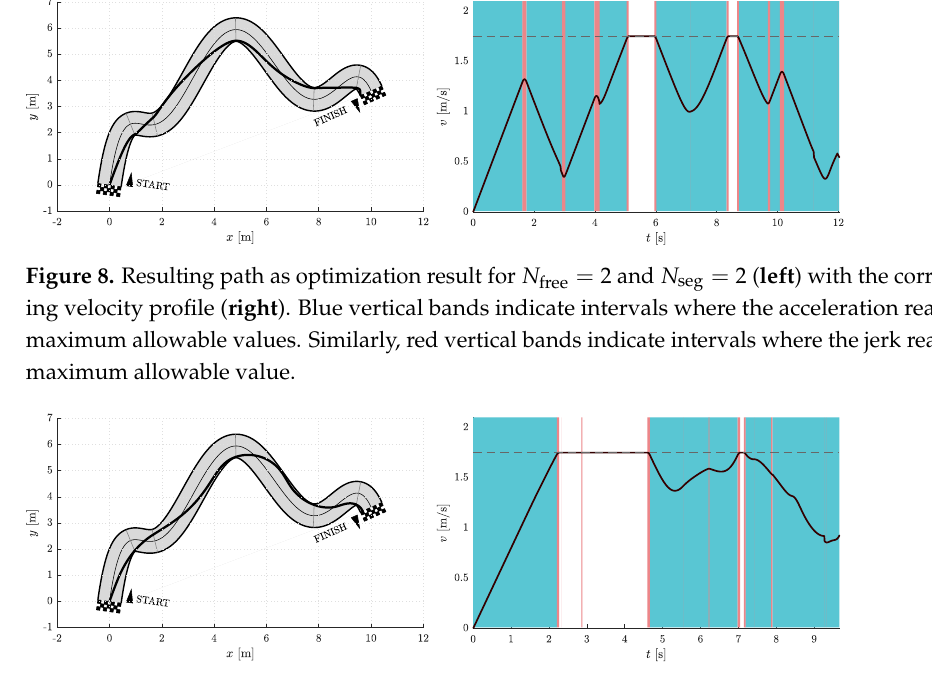
Figure 9. Resulting path as optimization result for N free = 5 and N seg = 2 ( left ) with corresponding velocity profile ( right ). Blue vertical bands indicate intervals where the acceleration reaches its maximum allowable values. Similarly, red vertical bands indicate intervals where the jerk reaches its maximum allowable value.